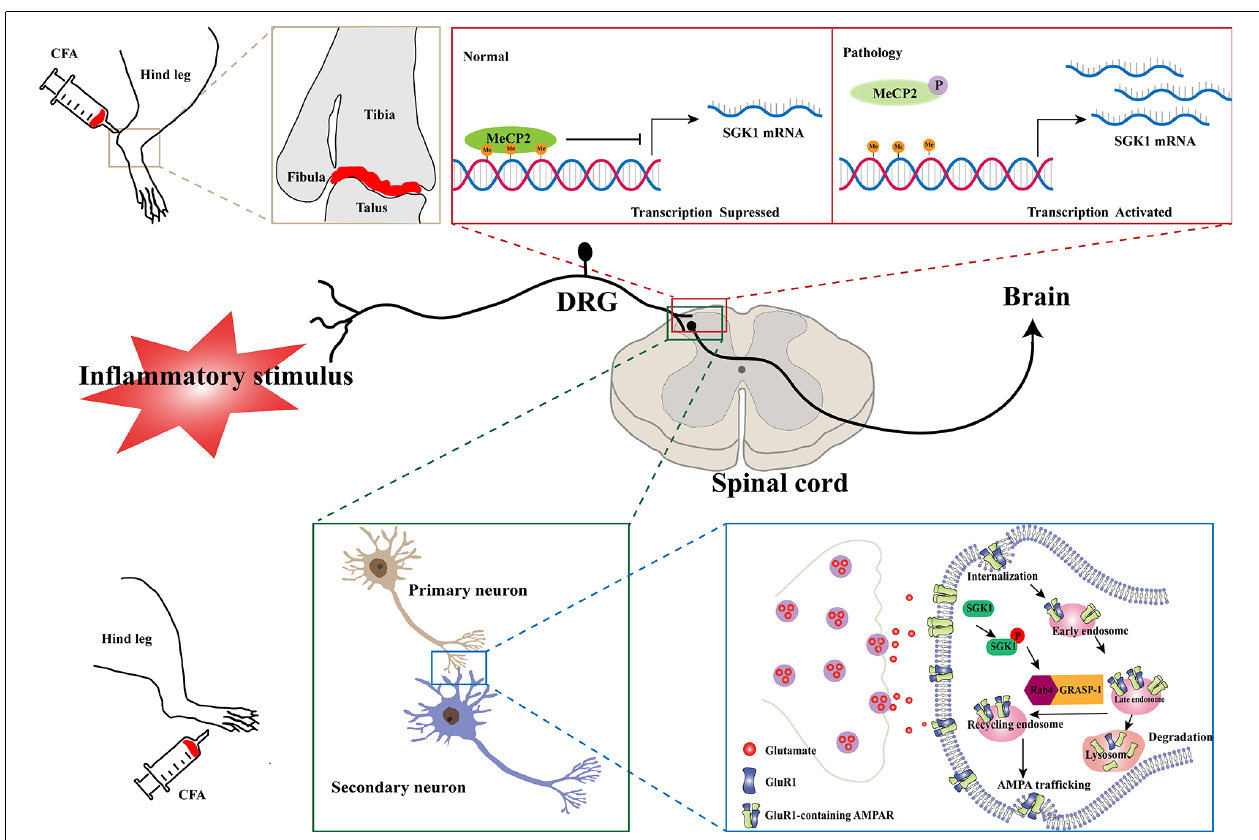
FIGURE 2 | Schematic illustration of potential mechanisms of SGK1 in the development of inflammatory pain. In a normal physiological state, the expression of SGK1 is repressed by the transcriptional repressor MeCP2. In a CFA-induced joint inflammatory state, MeCP2 is found to be phosphorylated after peripheral noxious stimulation and result in activation of SGK1 gene transcription (the upper panel). The GluR1-containing AMPARs are crucially involved in processing synaptic nociceptive inputs, and the trafficking and recruitment of GluR1-containing AMPARs increase glutamatergic synaptic transmission. The spinal SGK1 phosphorylation potentiates glutamatergic synaptic transmission by promoting GRASP-1/Rab4-dependent GluR1-containing AMPARs trafficking in the CFA-induced inflammatory pain model (the lower panel). SGK1, serum- and glucocorticoid-inducible kinase 1; CFA, complete Freund’s adjuvant; MeCP2, Methyl-CpG-binding protein 2; P, phosphorylation; Me, Methyl; DRG, dorsal root ganglion; Rab4, Ras-related protein 4; GRASP-1, glutamate receptor-interacting protein associated protein-1; AMPAR, a-amino-3-hydroxy-5-methyl-4-isoxazolepropionic acid